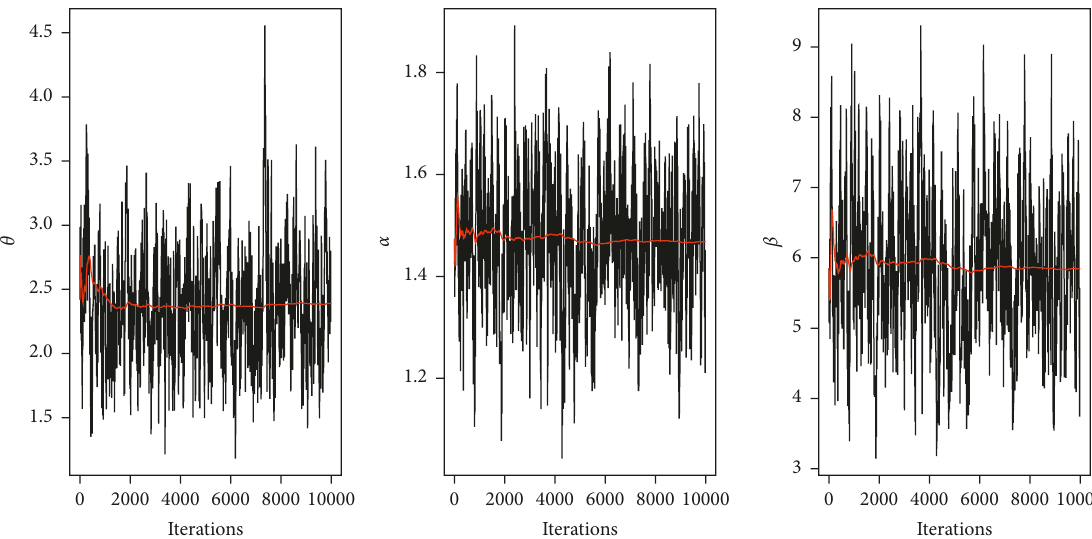
Figure 4: Trace of MCMC results and convergence of parameters for the MKKu distribution for COVID-19 data of Saudi Arabia. 0.00.20.40.60.81.0